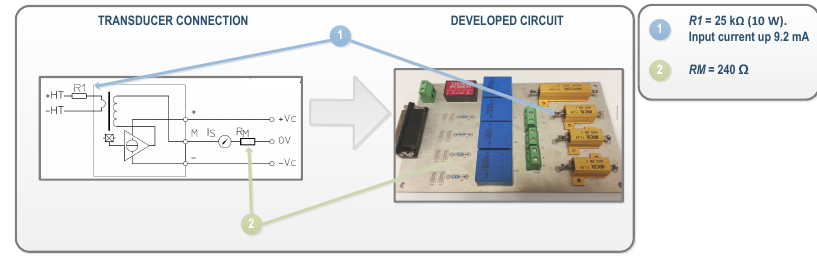
Figure 4. Signal Conditioning of the DC and AC voltage transducers. RM: multi-turn precision resistor.